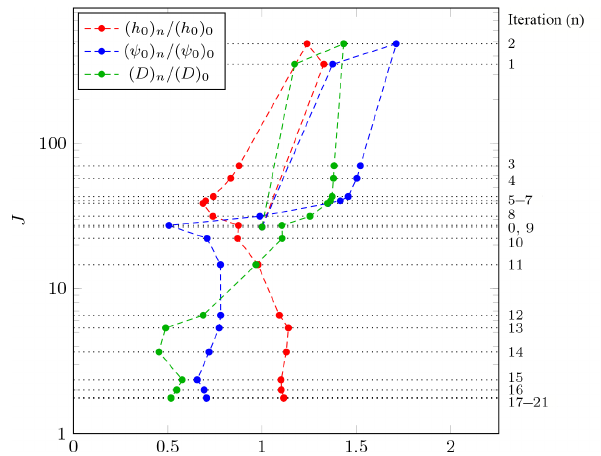
Figure 6. Values of the parameters over the optimisation iterations against the value of the objective functional, J , that we are aiming to minimise. The values shown are normalised by their starting values.